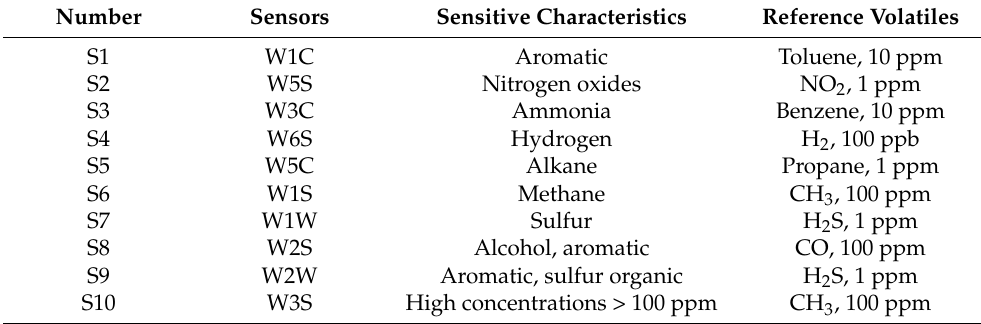
Table 1. The 10 sensors, sensitive characteristics, and reference volatiles of electronic